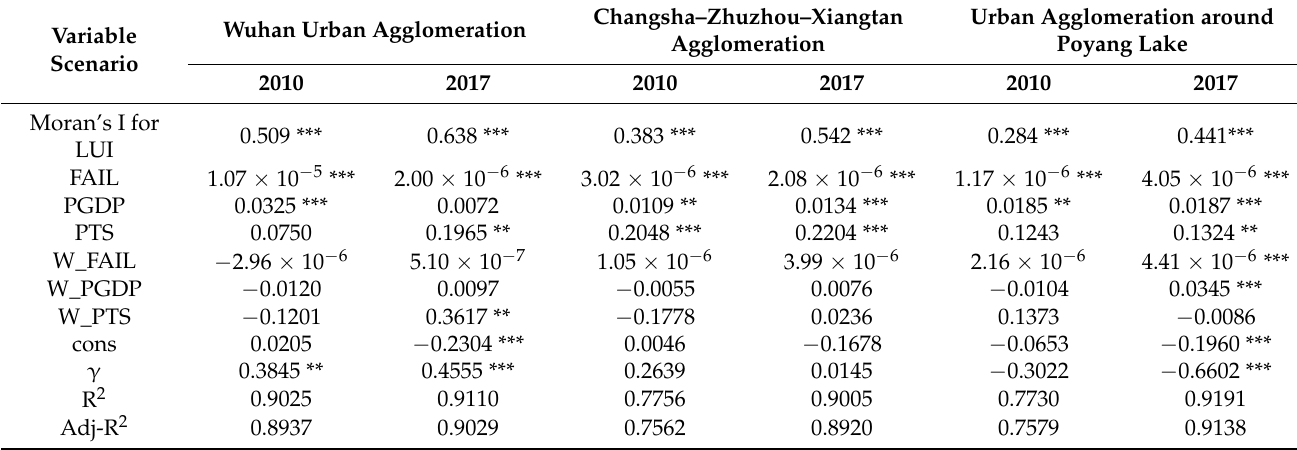
Table 5. Results of SDM in 2010 and 2017 of the three